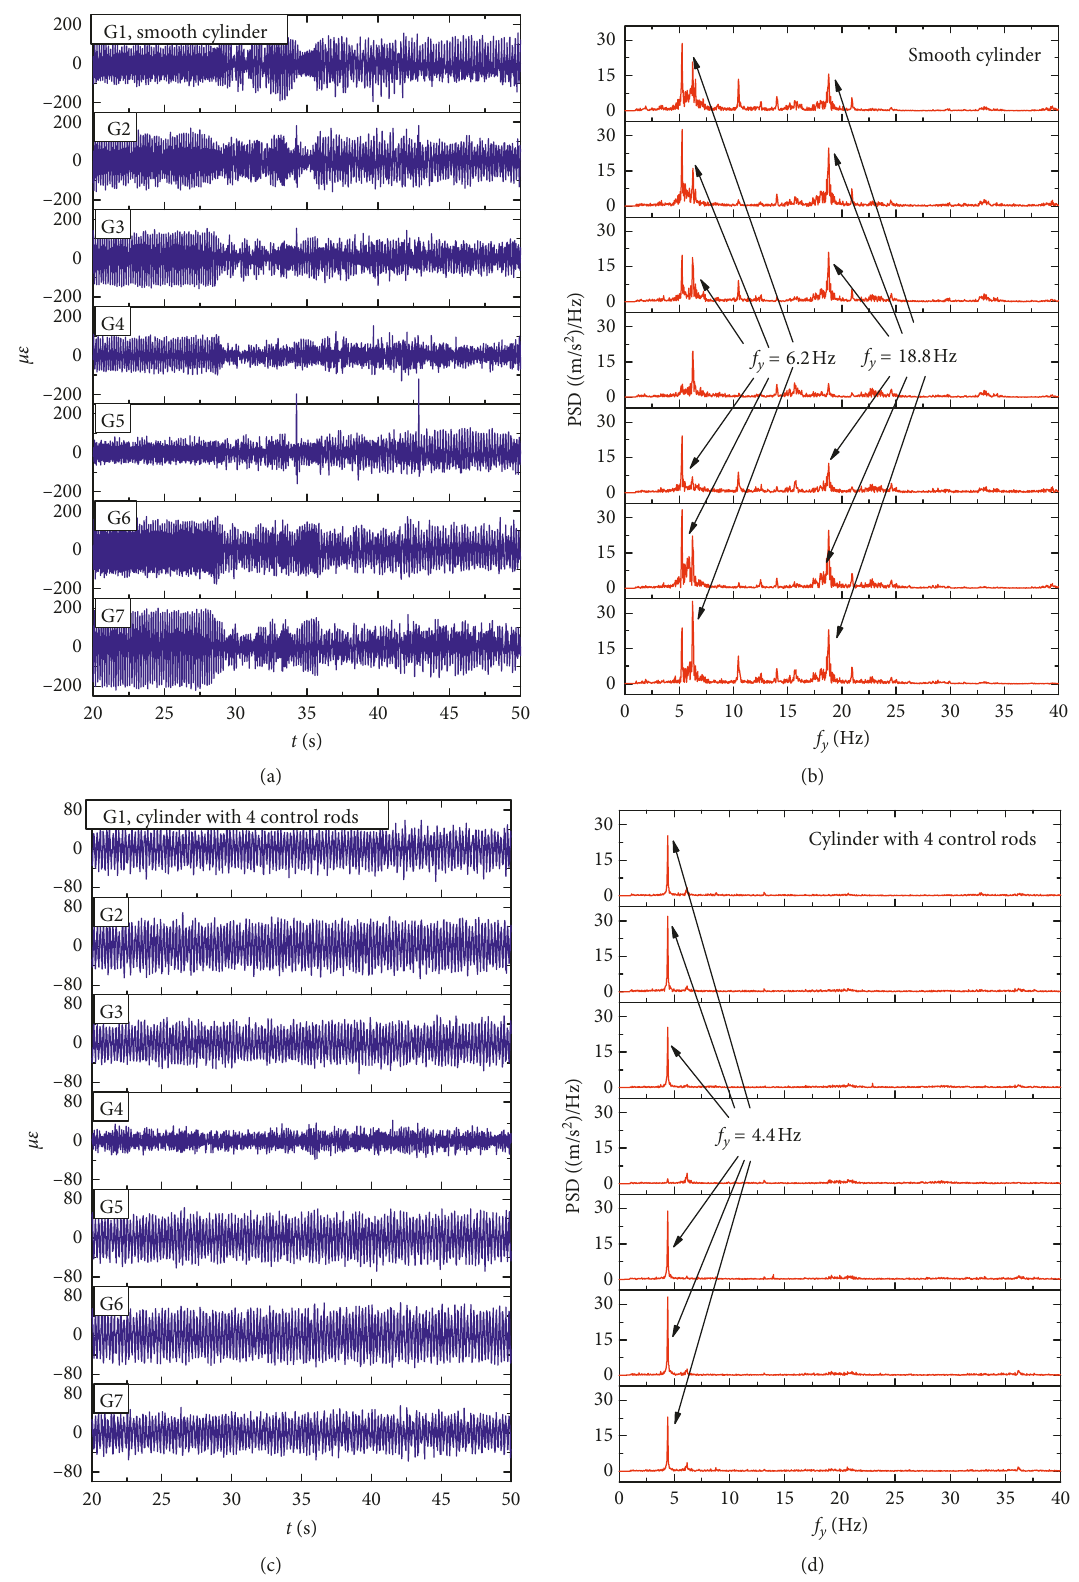
Figure 4: Strain response characteristic of the vertical flexible cylinder ( α U 0.60m/s (the first column presents time history of strain signals ((a), (c)) and the second column presents response spectra ((b), (cid:31)